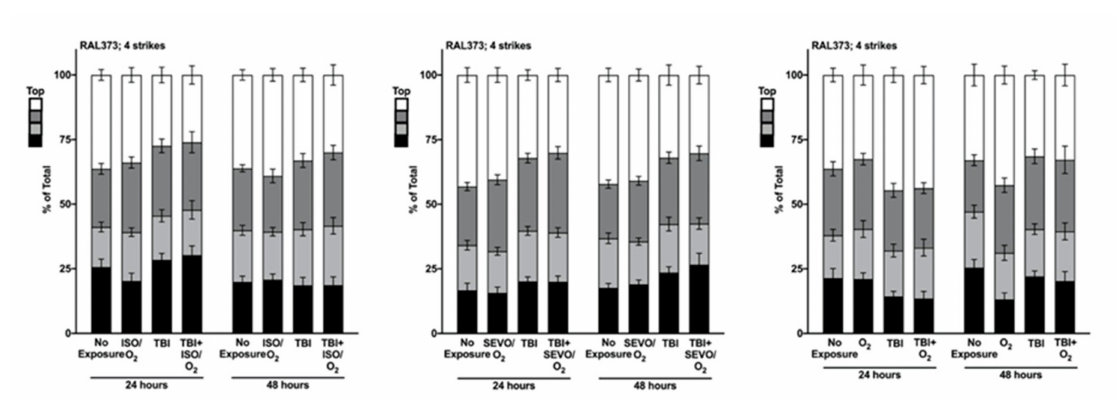
Figure A5. RAL761.